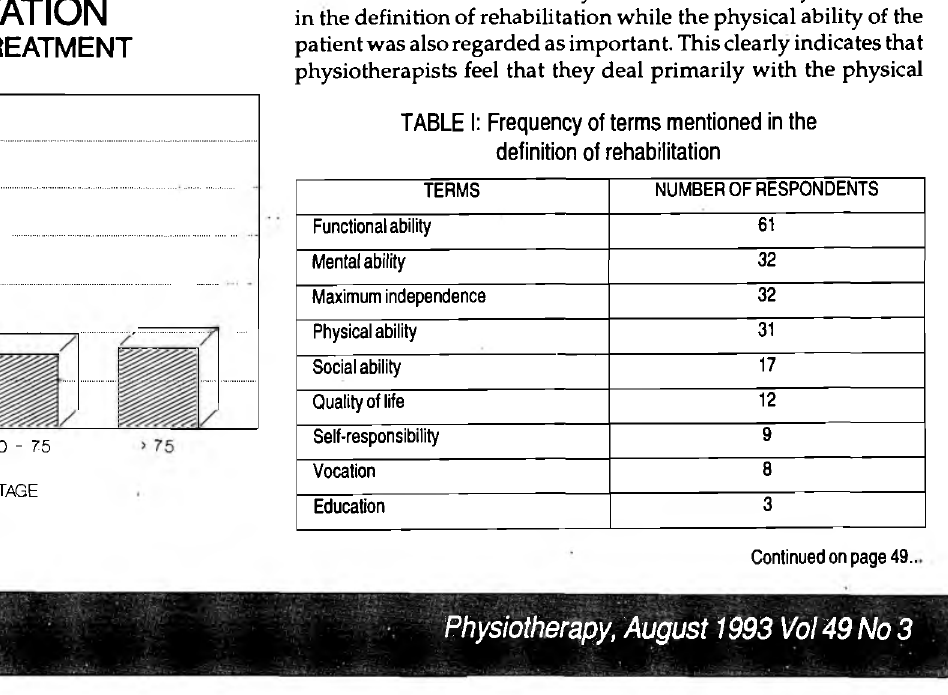
TABLE I: Frequency of terms mentioned in